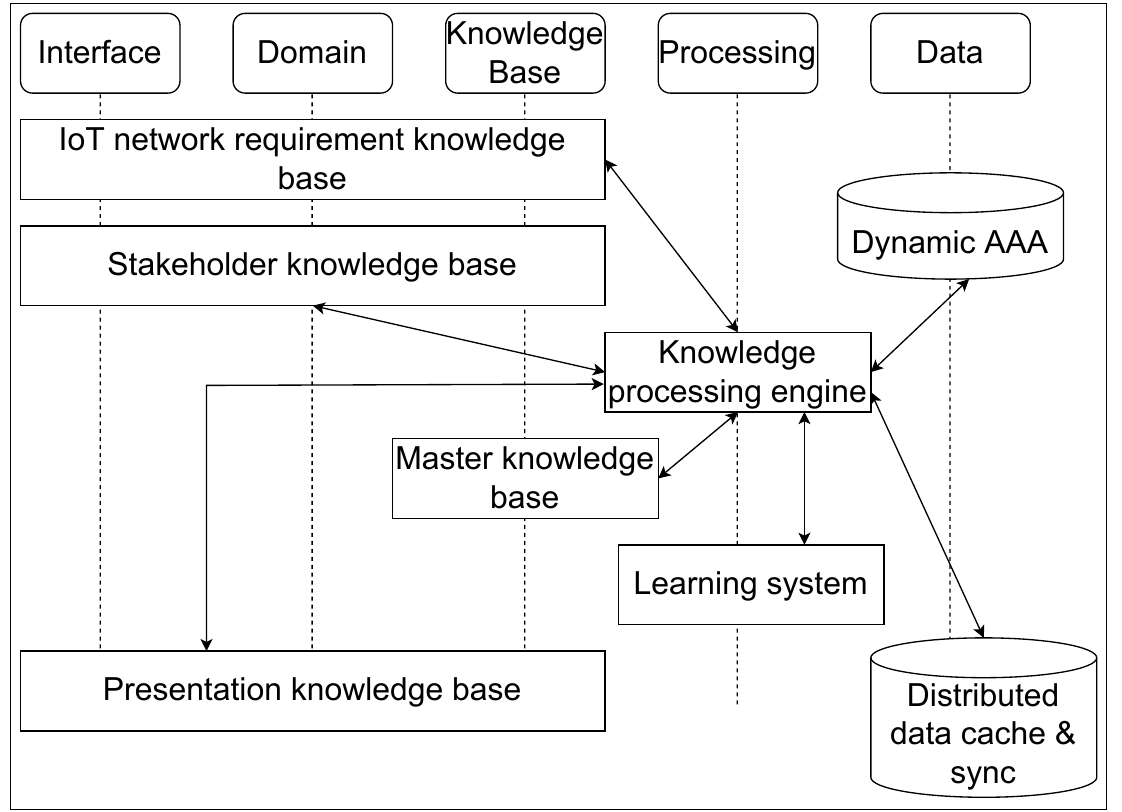
Figure 5. Interaction view of the main components of the smart AAA